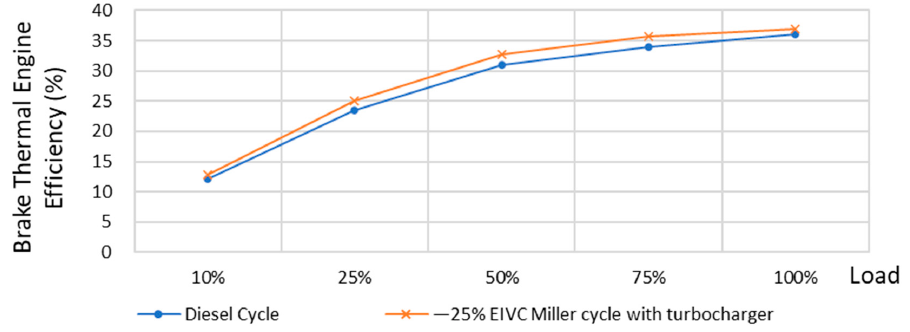
Figure 12. Comparison of BTEE between diesel engine and EIVC Miller cycle turbocharger diesel engine.